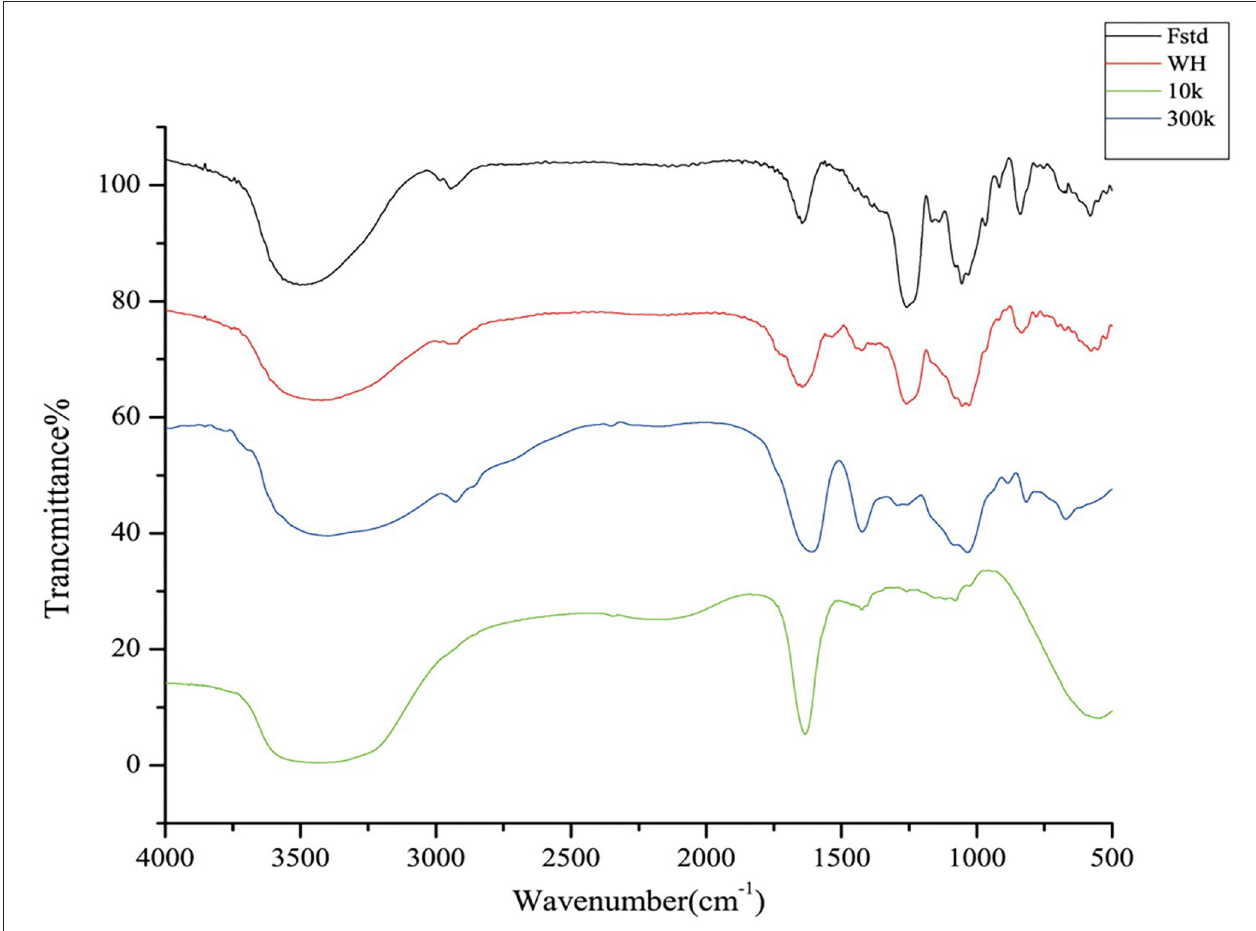
FIGURE 3 | FTIR spectrum of four fucoidan samples. Fstd = fucoidan standard ( ≥ 95%, CAS: 9072-19-9). WH = fucoidan crude extract. 300k = fucoidan fraction with molecular weight over 300 kDa. 10k = fucoidan fraction with molecular weight < 10